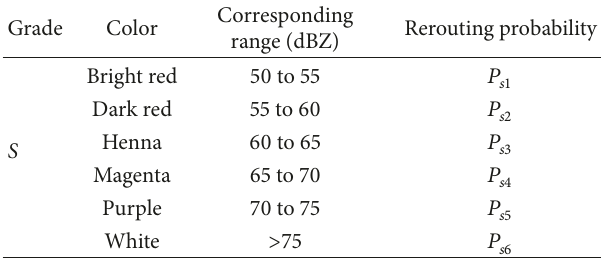
Table 4: Rerouting probabilities when passing the region with S - class